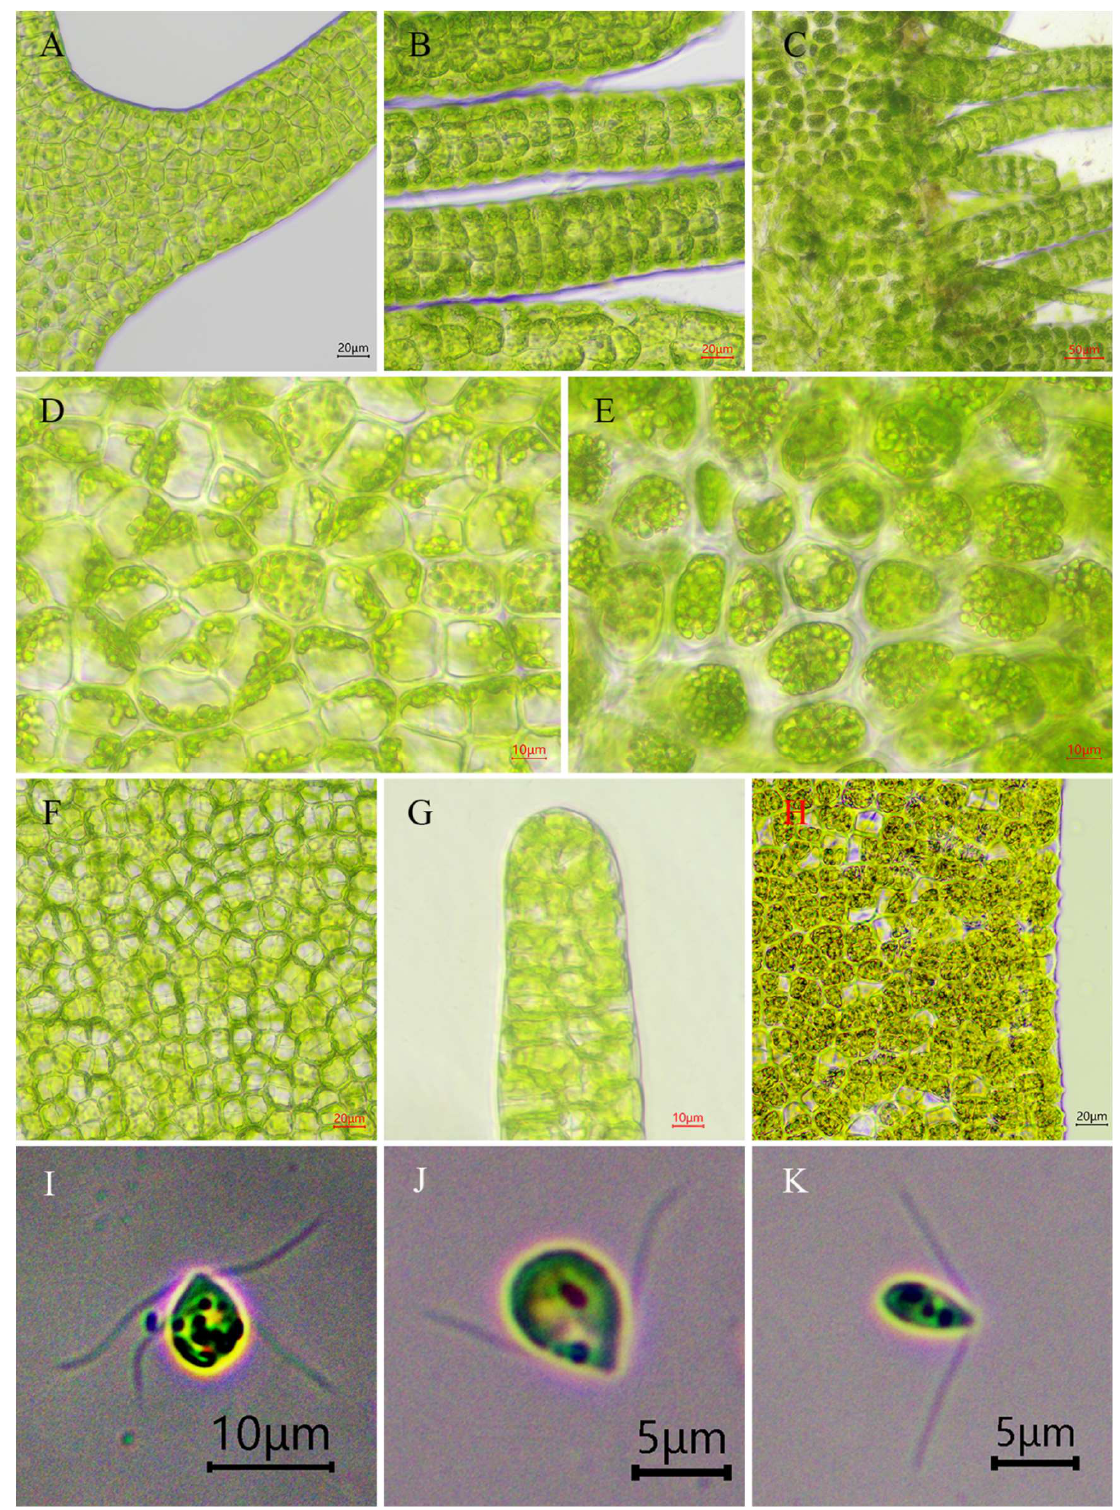
Figure 3. Microscopic observation of Ulva meridionalis : ( A ) main branch; ( B , C ) proximity of the horizontal branch to the base area; ( D ) surface view of cells in the basal portion; ( E ) cells containing many pyrenoids; ( F ) surface view of cells in the middle region; ( G ) surface view of cells in the upper region; ( H ) gametangium; ( I ) tetraflagellate meiospore; ( J ) biflagellate female gamete; and ( K ) biflagellate male gamete.